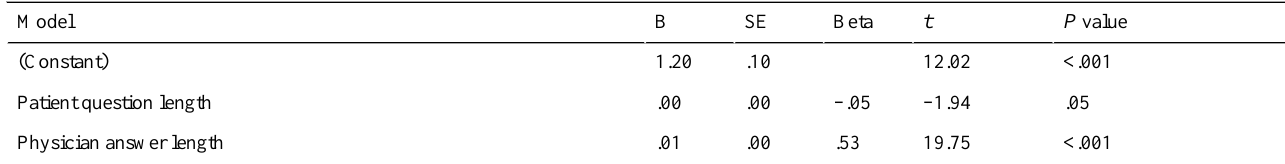
Table 3. Summary of regression analysis for patient question length and physician answer length predicting response time (minutes)